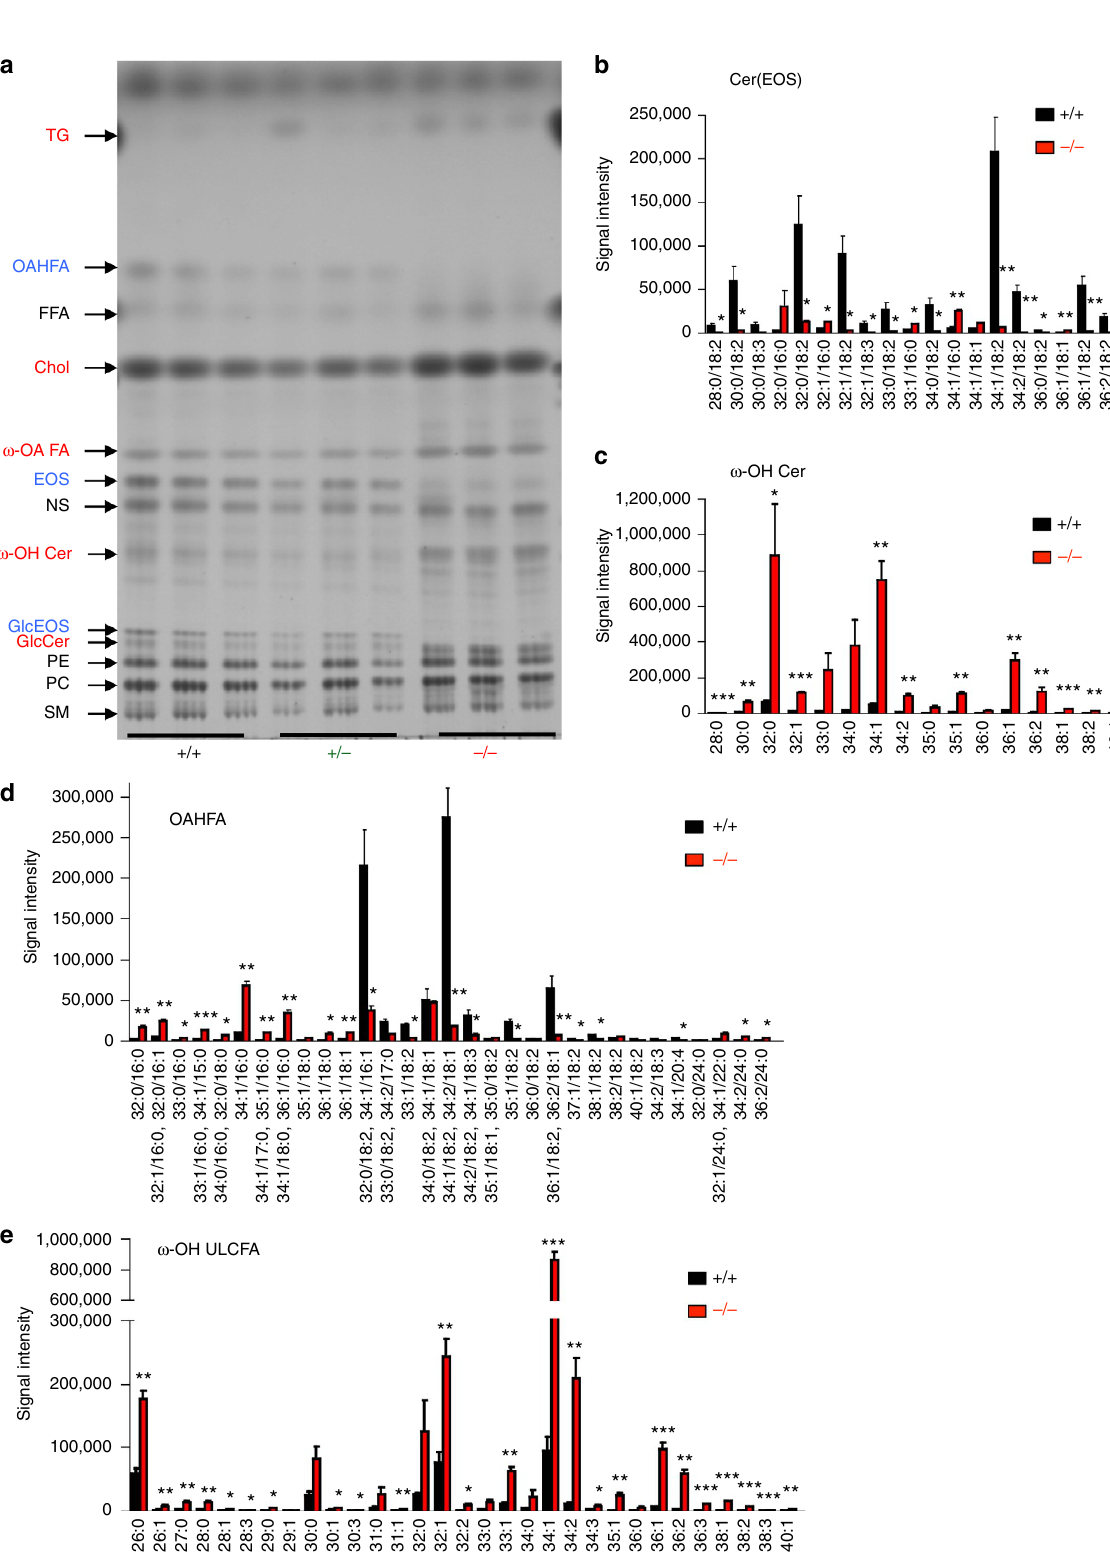
Figure 3 | Impaired acylceramide formation in Pnpla1 (cid:2) / (cid:2) epidermis. ( a ) Representative TLC analysis of lipids extracted from Pnpla1 þ / þ , Pnpla1 þ / (cid:2) and Pnpla1 (cid:2) / (cid:2) epidermis. In Pnpla1 (cid:2) / (cid:2) mice, EOS, GlcEOS and OAFHA were almost completely depleted (blue), with reciprocal increases in o -OH FA, o - OH Cer and GlcCer (red), relative to Pnpla1 þ / þ and Pnpla1 þ / (cid:2) mice. TG, triglyceride; FFA, free fatty acid; Chol, cholesterol; PE, phosphatidylethanolamine; PC, phosphatidylcholine: SM, sphingomyelin. ( b – e ) LC–MS/MS analysis of epidermal ceramide and related lipid species showing marked reductions in EOS ( b ) and OAHFA ( d ) species with linoleic acid (18:2) and increases in corresponding o -OH Cer ( c ) and o -OH ULCFA ( e ) species in Pnpla1 (cid:2) / (cid:2) mice in comparison with Pnpla1 þ / þ mice (mean ± s.e.m., n ¼ 3 animals; * P o 0.05, ** P o 0.01 and *** P o 0.001 versus Pnpla þ / þ mice). In b , c , C18-sphingosine-based ceramide (d18:1) species are selected and shown. Results from one or two independent experiments are